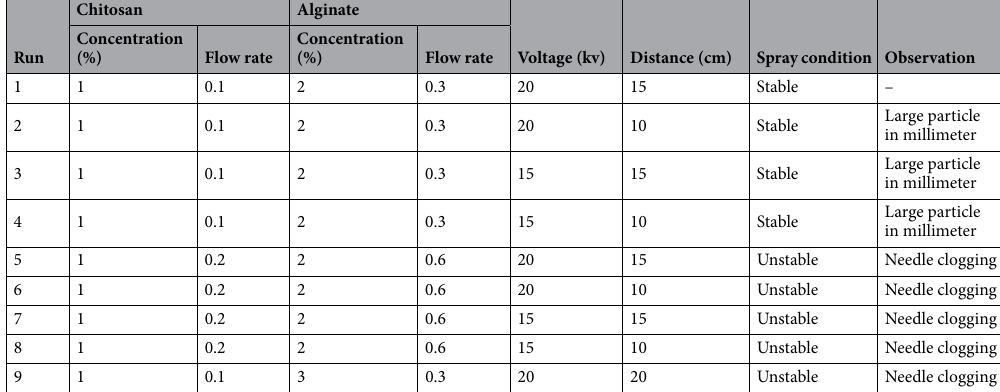
Table 1. Optimization of the chitosan-alginate core–shell particles according to the related parameters.